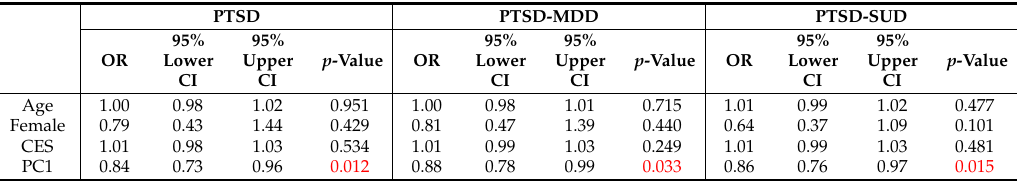
Table 5. Gene-level association with PTSD (i.e., individuals with only Posttraumatic Stress Disorder), PTSD-MDD (i.e., comorbid Posttraumatic Stress Disorder and Major Depressive Disorder), and PTSD-SUD (i.e., comorbid Posttraumatic Stress Disorder and Substance Use Disorder), adjusting for age, sex, and CES in